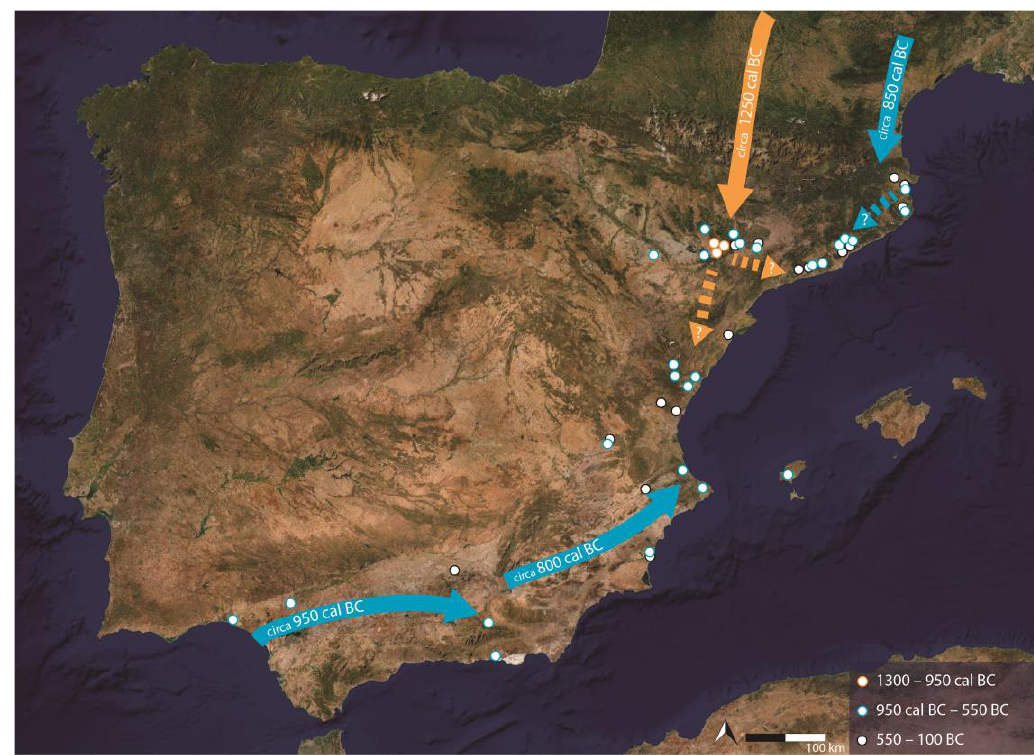
Figure 4. Schema illustrating the different routes serving to introduce millets cultivation by chron- ological phase. logical